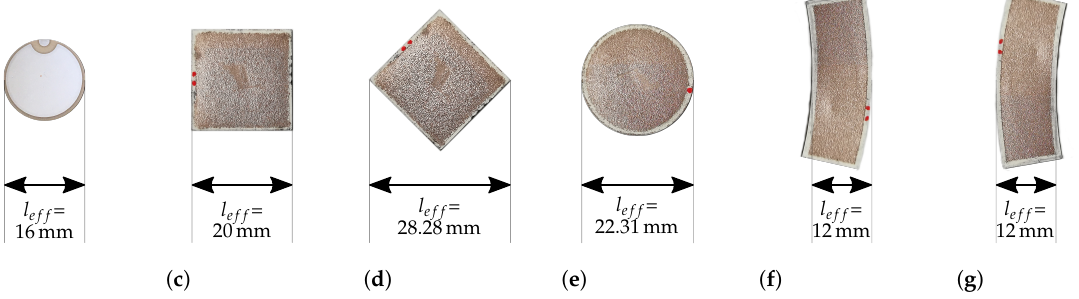
Figure 2. Sensor shapes under investigation with regard to the wave propagation direction and assumptions concerning the effective sensor length in wave propagation direction. ( a ) Wave front of a circular wave field. ( b ) Commercial Piezoceramic PRYY-1126. ( c ) Sensor shape: square,